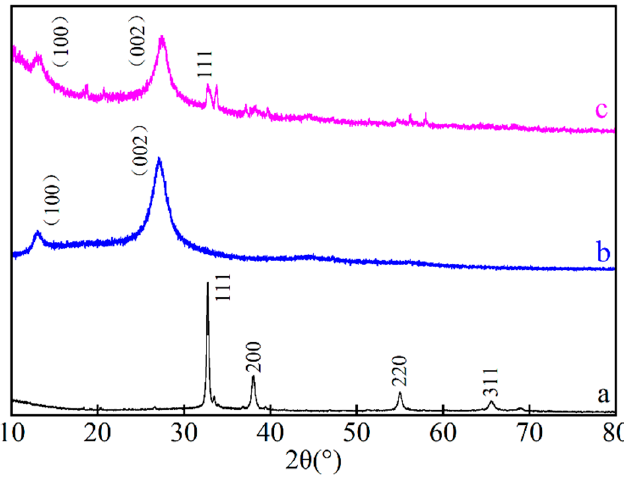
Figure 2. XRD spectrograms of Ag 2 O ( a ), g ‐ C 3 N 4 ( b ), and Ag 2 O/g ‐ C 3 N 4 ( c ).